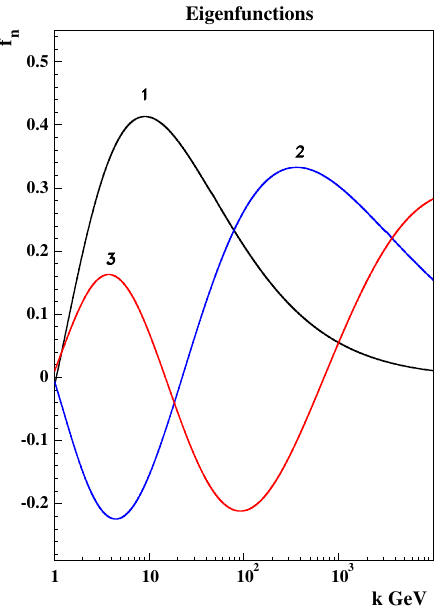
equal to 10 GeV − 2 . The first eigenfunction is plotted with the phase which decouples it from the proton